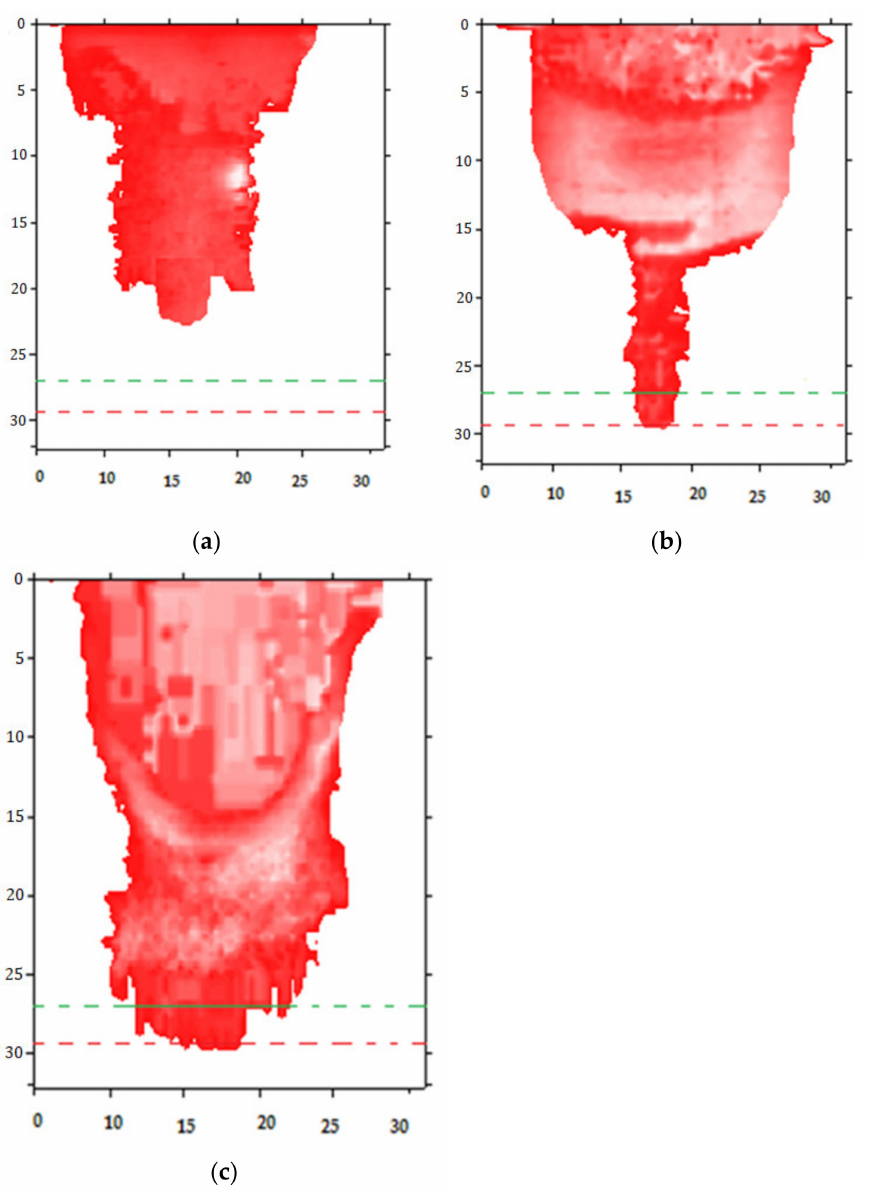
Figure 5. Samples of the image analysis showing the diesel behavior using ( a ) 50 mL, ( b ) 100 mL, and ( c ) 150